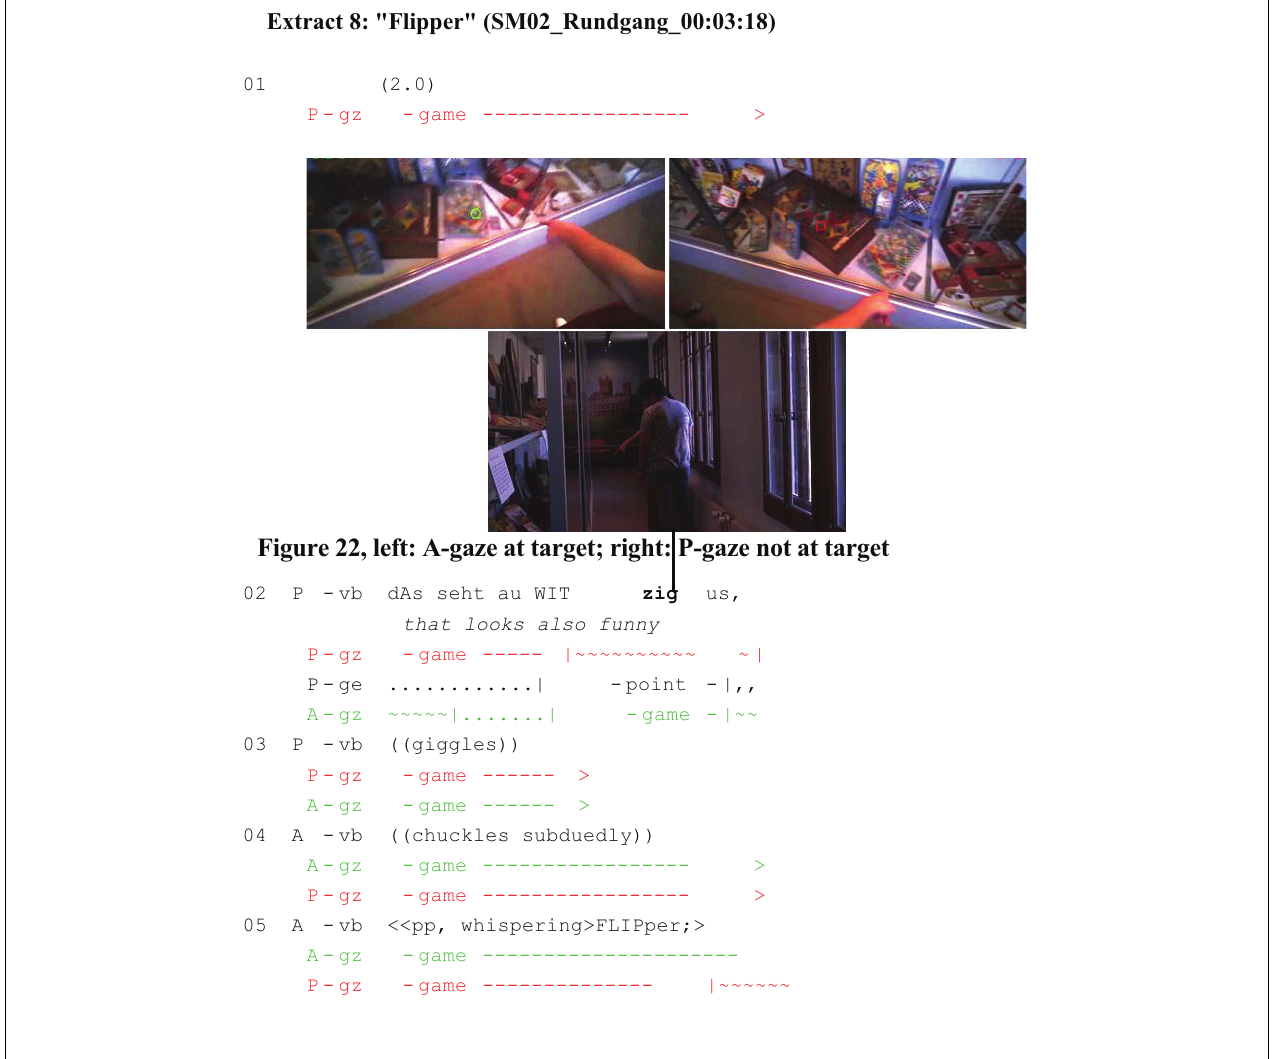
Figure 22, left: A-gaze at target; right: P-gaze not at